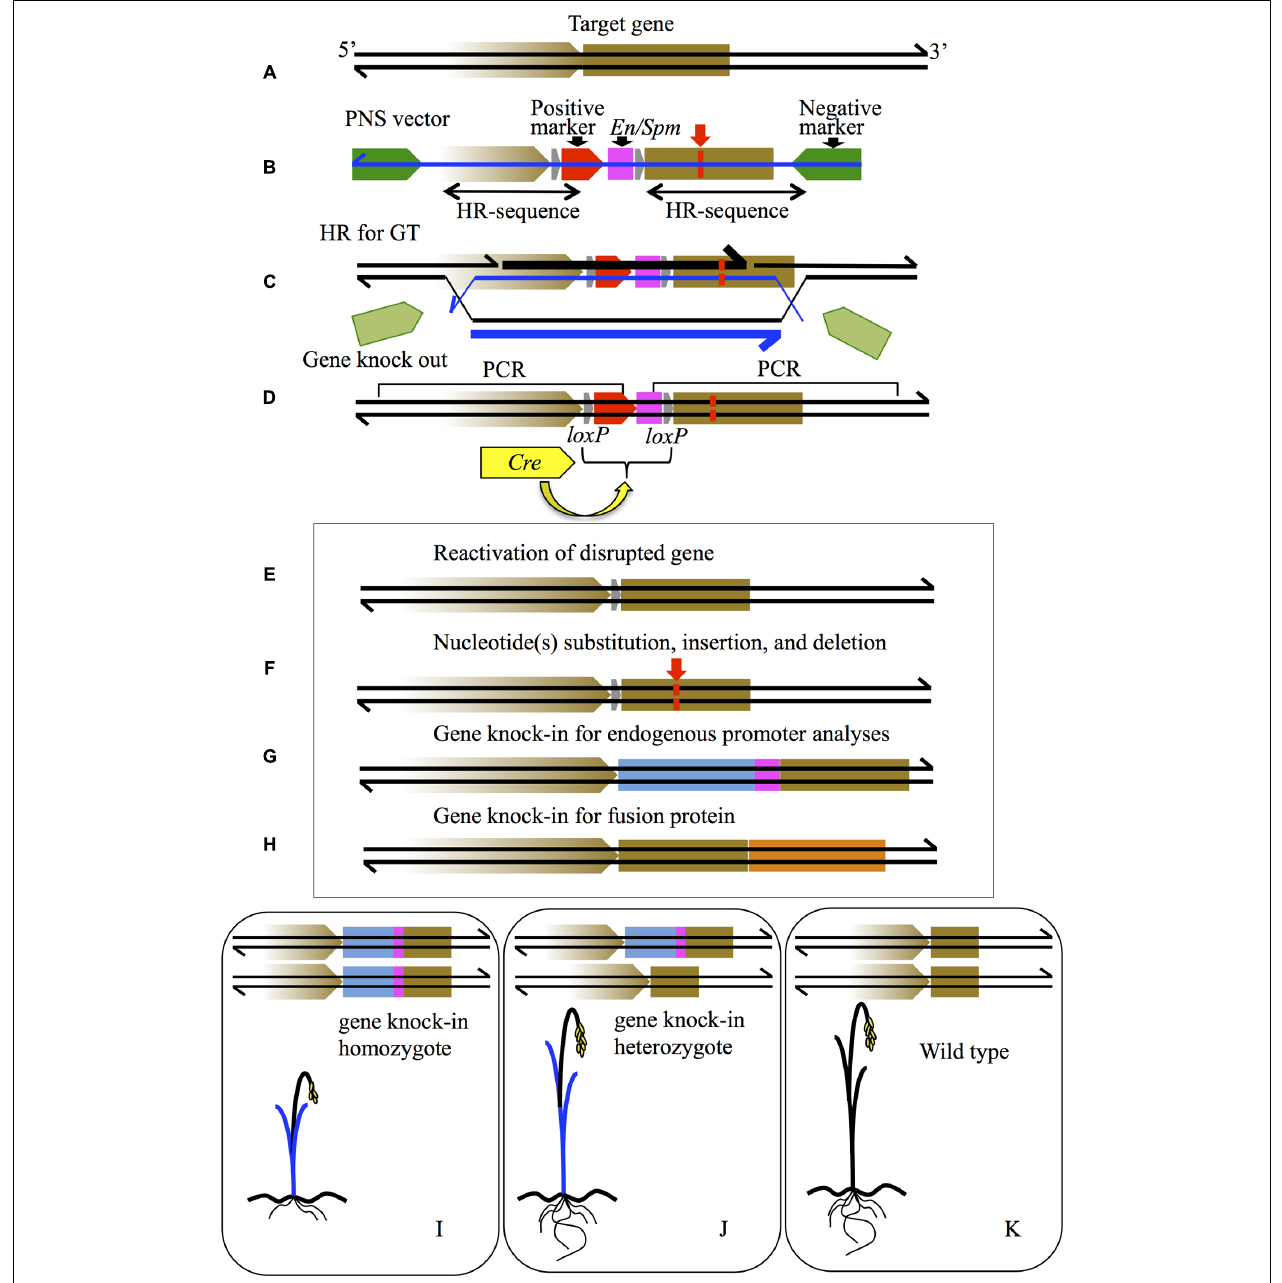
of knock-out gene in (D) by Cre- loxP recombination. (F) Nucleotide(s) substitution (red lines), insertion, and deletion in the target gene can be induced by designing a homology arm in the PNS vector in (B) and subsequent positive marker elimination by Cre- loxP recombination in (D) . (G) Gene knock-in modification where the endogenous promoter sequence is connected to the GUS coding sequence (indicated as a blue box with En/Spm ). (H) Gene knock-in modification where the mOrange coding sequence, indicated as an orange box, is connected precisely to the stop codon of the target gene; both endogenous promoter activity and protein localization of the target gene are detectable. (I–K) Diagrams of segregated plants from knock-inT 0 into homozygote (I) , heterozygote (J) , and wild type (K) . GUS expression image as blue leaves is shown in (I,J) . Dwarf phenotype in (I) is a reflection of the disrupted target